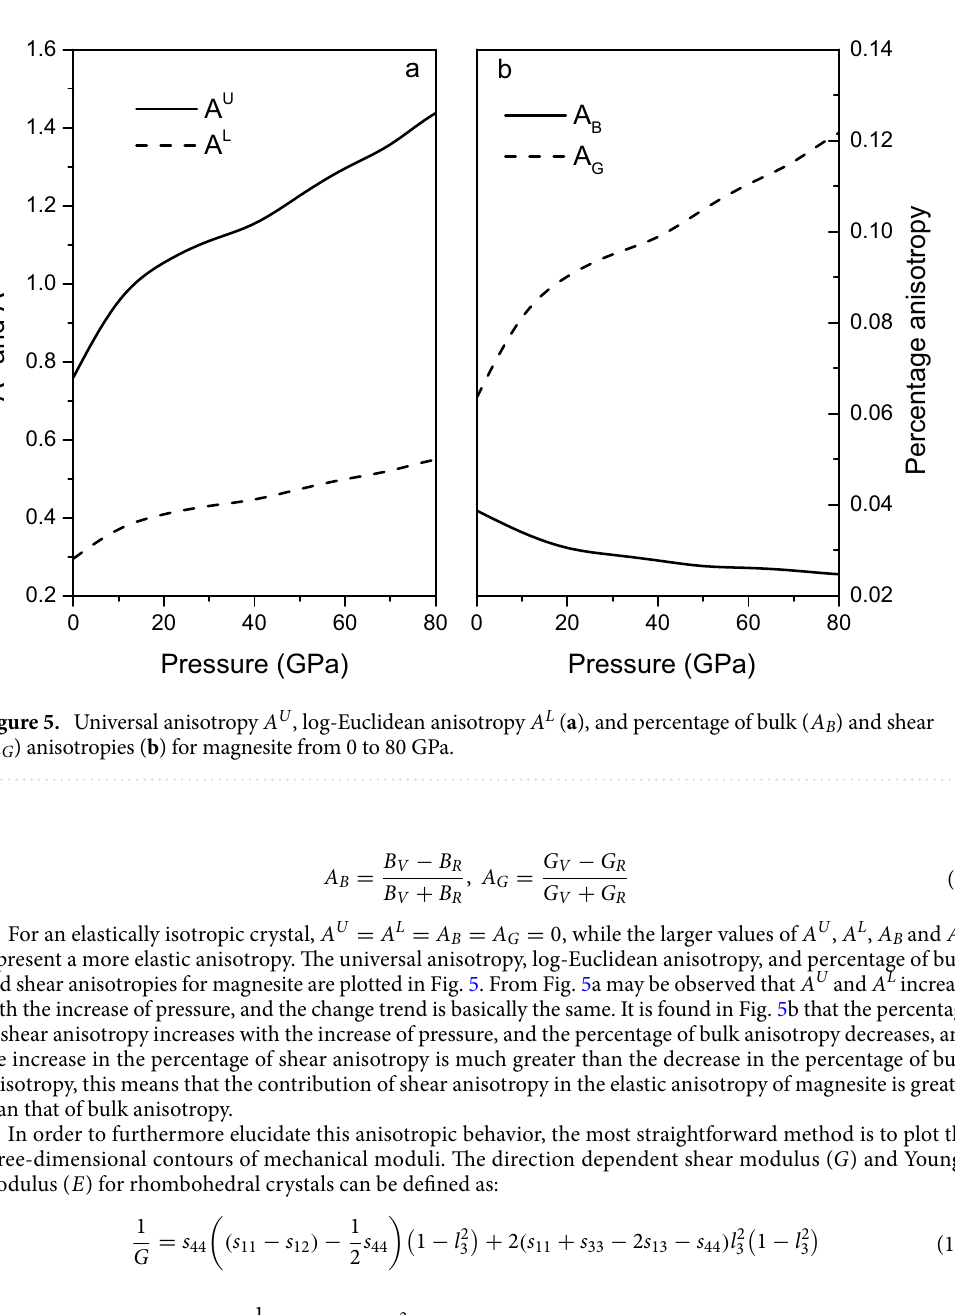
Figure 5. Universal anisotropy A ( A G ) anisotropies ( b ) for magnesite from 0 to 80